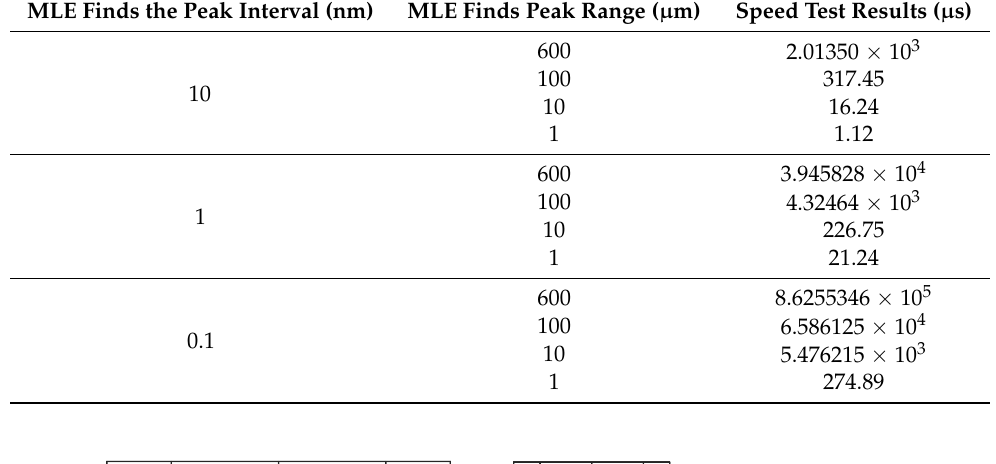
Figure 3. ( a ) The spectrum of FFT and MLE and ( b ) detail of the corresponding spectral peaks (Assuming L = 500 μ m).